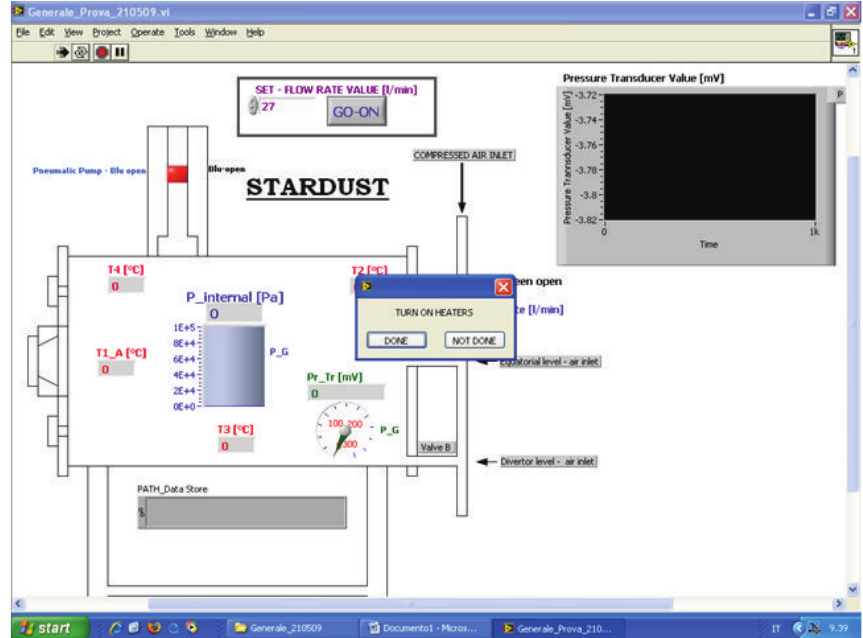
Figure 12: Labview software for STARDUST control.